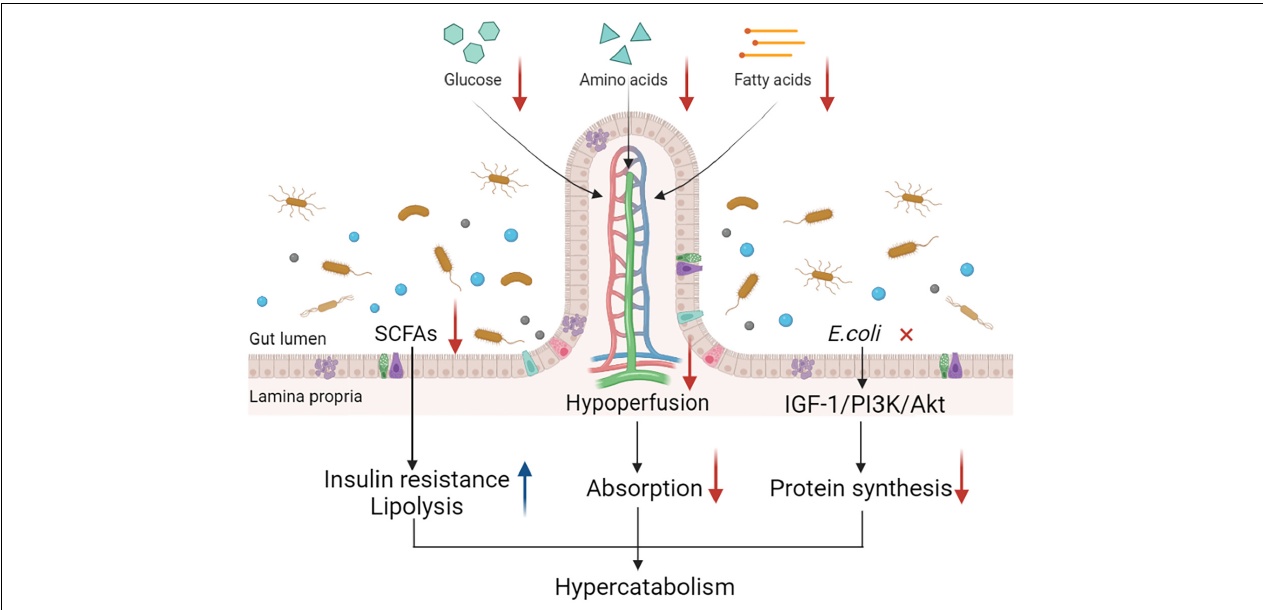
FIGURE 2 | Gut dysfunction and its impact on catabolism. Gut dysfunction contributes to a hypercatabolic state in many ways. Gut hypoperfusion and increased epithelial apoptosis contribute to the intestinal barrier impairment, which is common in critically ill patients, leading to the increase in gut permeability and further hindering nutrient absorption from the small intestine. Alterations in intestinal microbiota such as Escherichia coli decrease protein synthesis through the IGF-1/PI3K/Akt signaling pathway. Changes in microbiota-derived metabolites such as SCFAs also lead to the development of hypercatabolism by inducing insulin resistance and lipolysis. Together, these alterations contribute to the hypercatabolic status in patients with PICS. IGF-1, insulin-like growth factor-1; PI3K, phosphoinositide 3-kinase; SCFAs, short-chain fatty acids; PICS, persistent inflammation, immunosuppression, and catabolism syndrome.